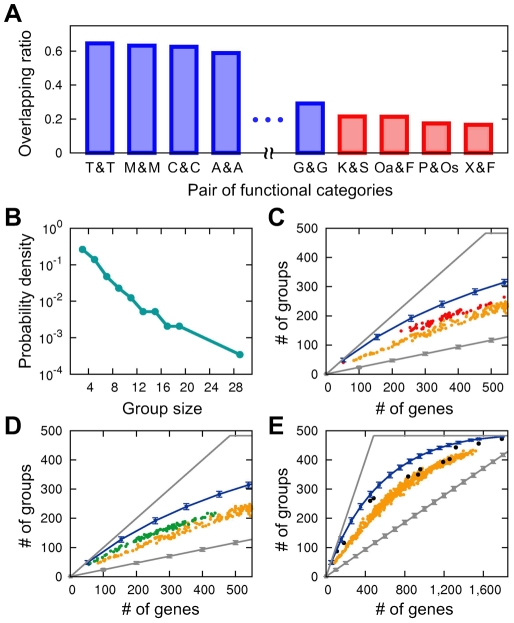
Characteristics of correlog groups in the MRS.(A) Plotted in descending order is how likely genes in a given pair of functional categories belong to the same correlog groups (plotted for P<10−3). Data of intermediate values are omitted for visual clarity, and all of them can be found in Table S4. Blue is for the same functional categories in a pair, and red is for different functional categories in a pair. Functional categories are abbreviated as the followings. T: Membrane transport; M: Cell motility; C: Carbohydrate metabolism; A: Amino acid metabolism; G: Glycan biosynthesis and metabolism; K: Kinase and peptidase; S: Signal transduction; Oa: Metabolism of other amino acids; F: Folding, sorting and degradation; P: Biosynthesis of polyketides and terpenoids; Os: Biosynthesis of other secondary metabolites; X: Xenobiotics biodegradation and metabolism. (B) The probability density of the number of genes in each correlog group. (C–E) Clustering of genes from individual species and environmental samples. For each bacterial species, the number of genes mapped to the MRS (x axis) and the number of different correlog groups including the genes (y axis) are plotted in yellow. In the same way, for each archaeal species, plotted in red in (C), for each eukaryotic species, plotted in green in (D), and for each environmental sample, plotted in black in (E). In (C)–(E), for comparison with the null model, the number of different correlog groups including randomly mapped genes is plotted in blue with the error bars representing standard deviations. Although for some data points the error bars in blue look overlapped with the symbols in red and green, this is simply because of the large size of the symbols used to facilitate visual examination. Gray lines at the upper and lower sides in (C)–(E) denote the number of different correlog groups with the most sparsely-distributed mapped genes and the maximally-crowded mapped genes, respectively, while the latter allows for multiple configurations of gene mappings having standard deviations denoted by error bars. In other words, the gray lines set the absolute limits of the number of different correlog groups for each number of genes. Most data points in yellow, red, green, and black are located far below blue error bars, illustrating significant clustering of genes around correlog groups across different domains of life and environmental microbial communities.